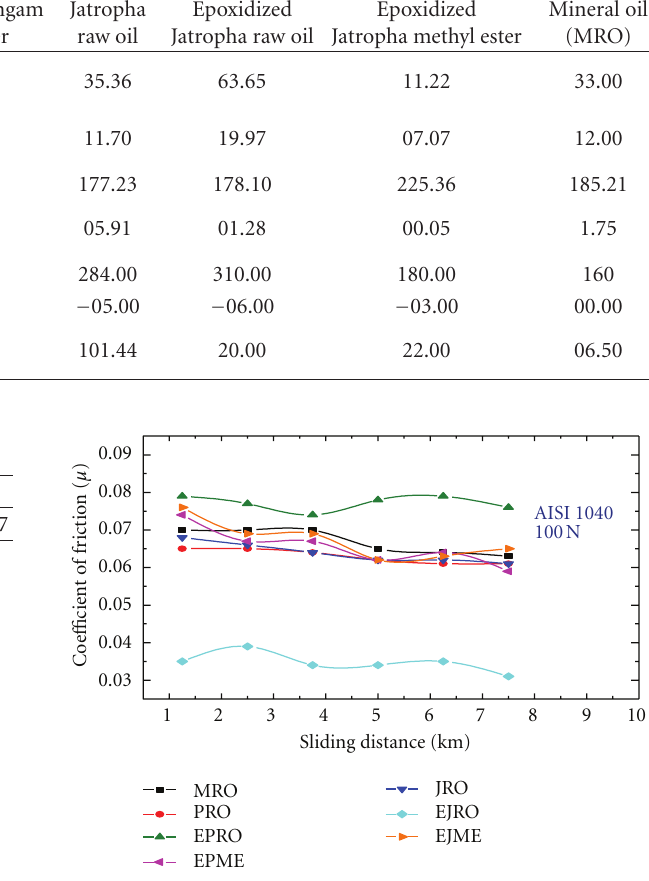
Figure 2: Variation of coe ffi cient of friction with sliding distance for